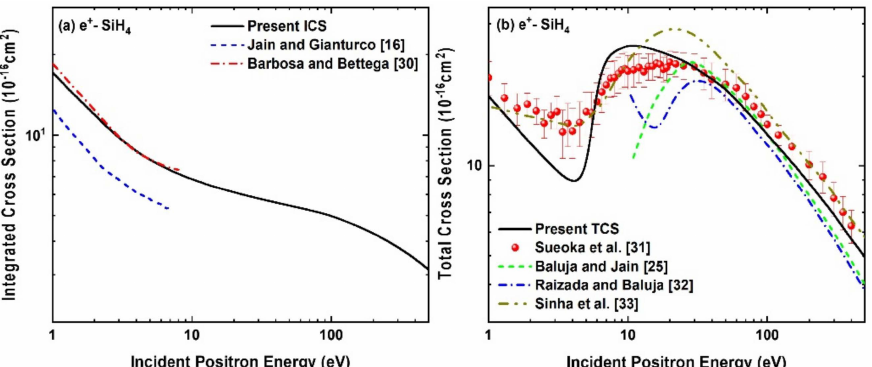
Figure 9. ( a ) Elastic integrated and ( b ) total cross section for positron-SiH 4 scattering as a function of incident positron energy. In ( a ); solid line, present ICS; dashed line, Jain and Gianturco [16]; dashed dot line, Barbosa and Bettega [30]; in ( b ); solid line, present TCS; solid sphere, Sueoka et al. [31]; dashed line, Baluja and Jain [25]; dashed dot line, Raizada and Baluja [32]; dashed double dot, Sinha et al.